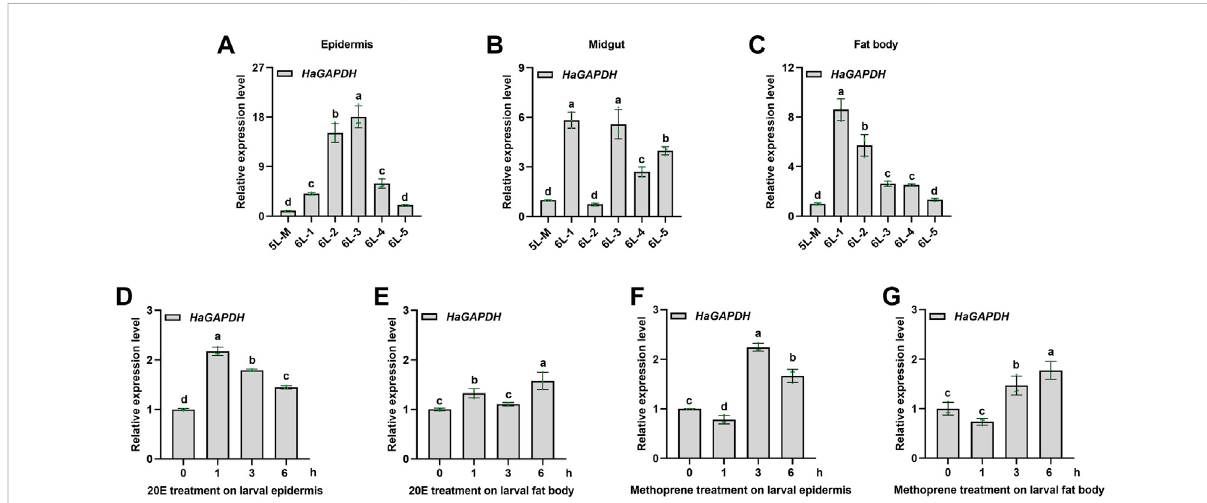
FIGURE 2 Expression pro fi le of HaGAPDH . (A – C) Transcript analyses of HaGAPDH in the epidermis (A) , midgut (B) , and fat body (C) from 5L-M to 6L- 5 days by qRT-PCR. 5L-M: the molting stage of the fi fth instar larvae, 6L-1: the fi rst day of the sixth instar larvae, (D) and (E) the transcript changes of HaGAPDH intheepidermis (D) andfatbody (E) underthe20Etreatment.Larvaeweretreatedwith1.2 μ g20E(5 μ l)orDMSO(5 μ l)for1,3,and6 h (F) and (G) thetranscript changesof HaGAPDH intheepidermis (F) and fatbody (G) undermethoprenetreatment.Larvae weretreated with0.5 μ g methoprene (5 μ l) or DMSO (5 μ l) for 1, 3, and 6 h. Ha18s and β -actin were used as the reference genes. The error bars indicated the mean ± s.d. of three independent biological experiments and three technical repetitions. Different letters indicate signi fi cant differences at the p < 0.05 level using the Tukey